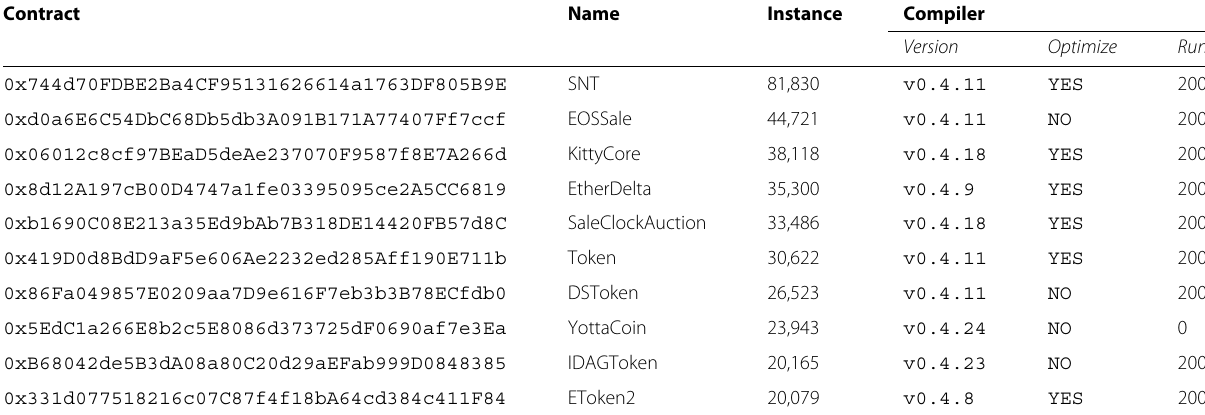
Table 6 A selected list of 10 smart contracts in our sample data set with verified source code available in Etherscan, ranking by number of receiving out of gas exceptions